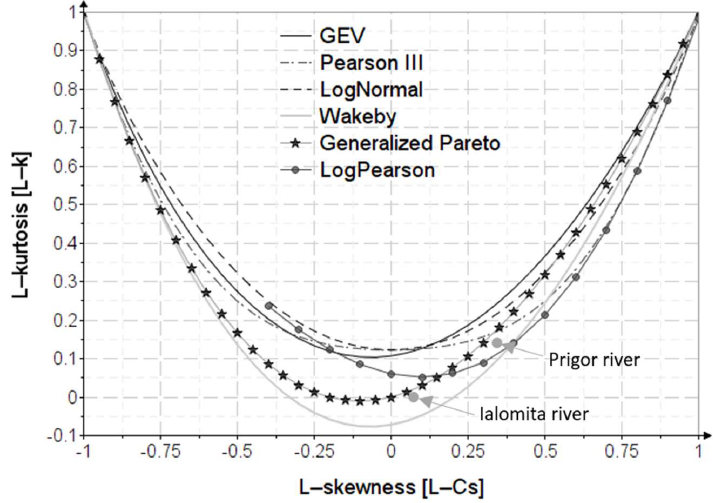
Figure 15. The variation of L-kurtosis–L-skewness with the sample data value of L-kurtosis and L-skewness.